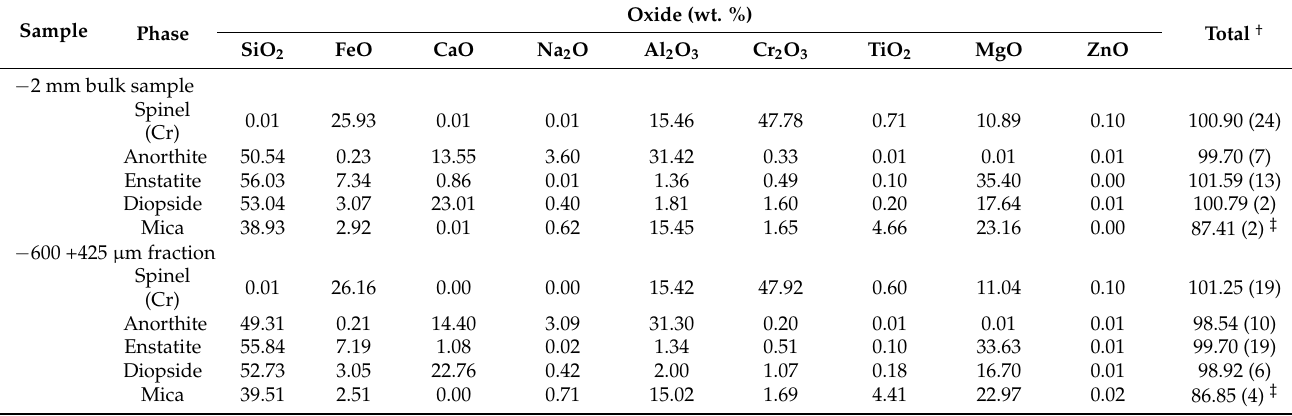
Table 3. The average quantitative EPMA data for key minerals in the − 2 mm bulk sample and the − 600 +425 µ m